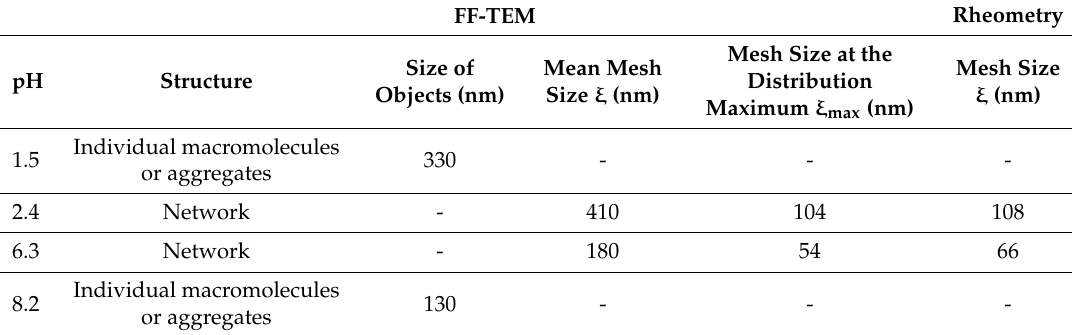
Table 1. Structural parameters obtained from FF-TEM micrographs and rheological measurements for 0.1 wt % xanthan aqueous solutions in the presence of CrCl 3 (molar ratio [CrCl 3 ] / [xanthan monomer units] = 1) prepared at di ff erent